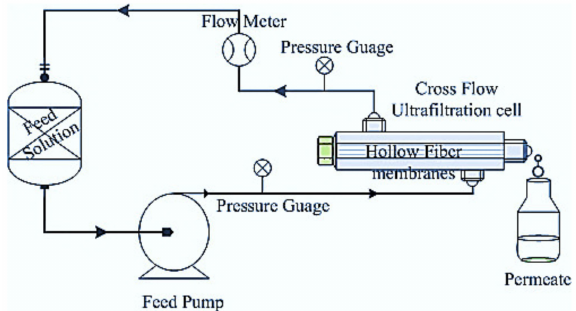
Figure 2. Schematic diagram of hollow fiber (out to in) cross flow filtration